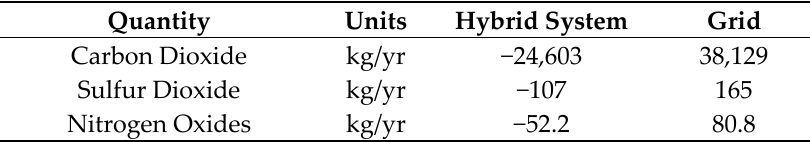
Table 3. Emissions from a hybrid system and a grid supply